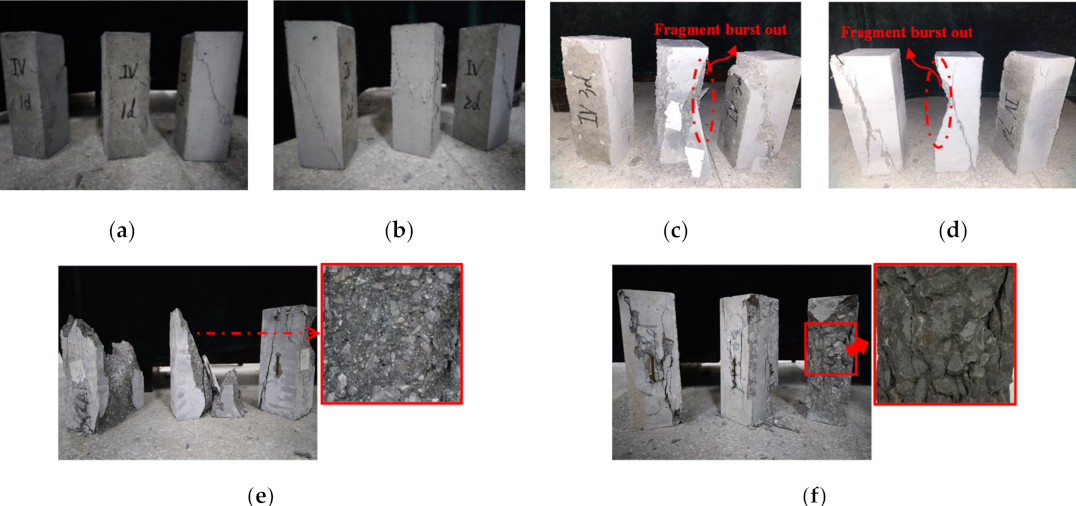
Figure 4. Typical failure modes of ( a ) IV-1 d; ( b ) IV-2 d; ( c ) IV-3 d; ( d ) IV-7 d; ( e ) IV-28 d; and ( f ) C-28 d specimens.